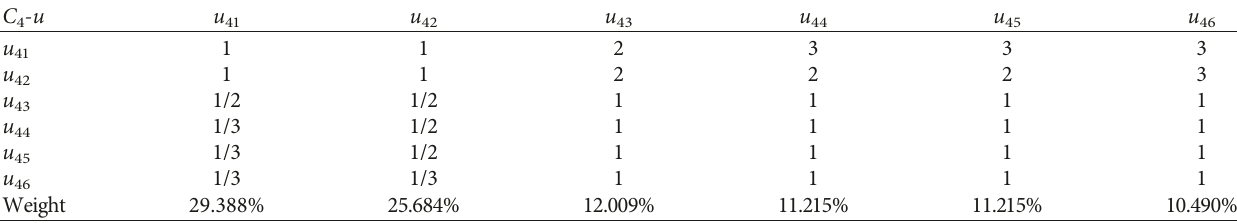
Table 13: Judgement matrix of the rule layer to the design of the shield machine ( C